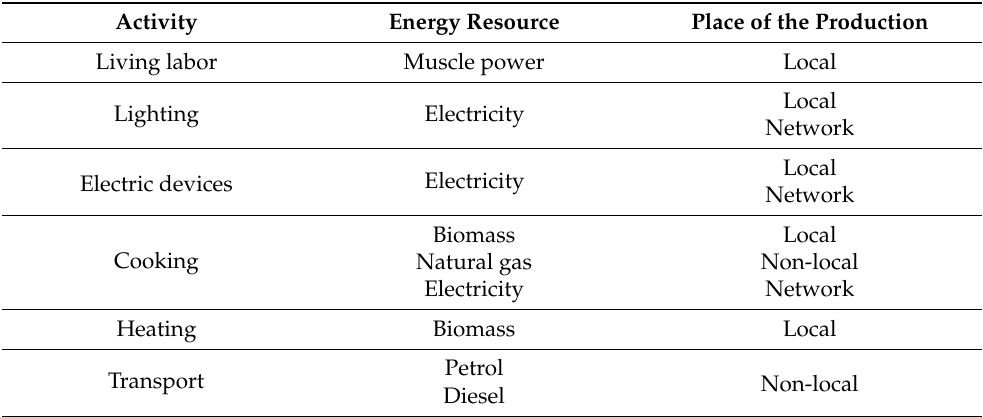
Table 1. Activities, energy resources, and place of production of households.